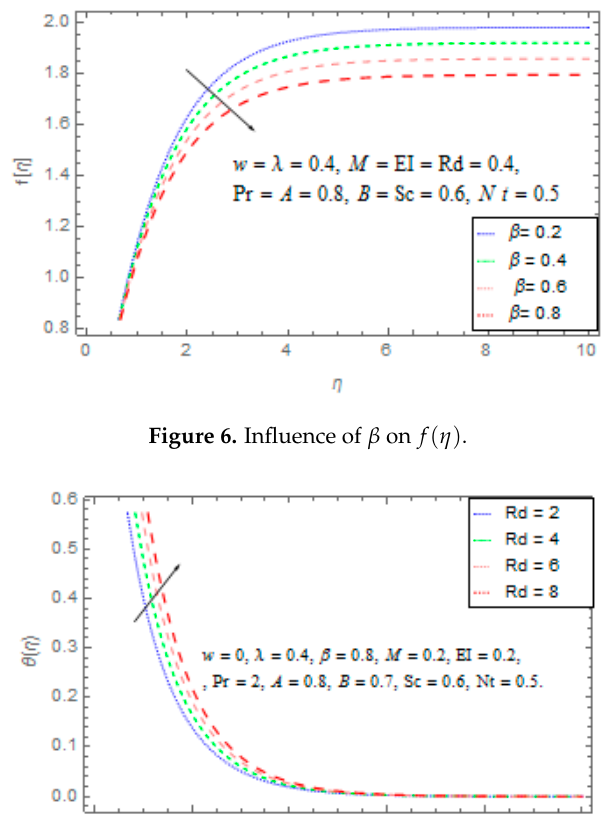
Figure 5. Influence of M on velocity Profile. Applied sciences 2018 , 17 , x FOR PEER REVIEW